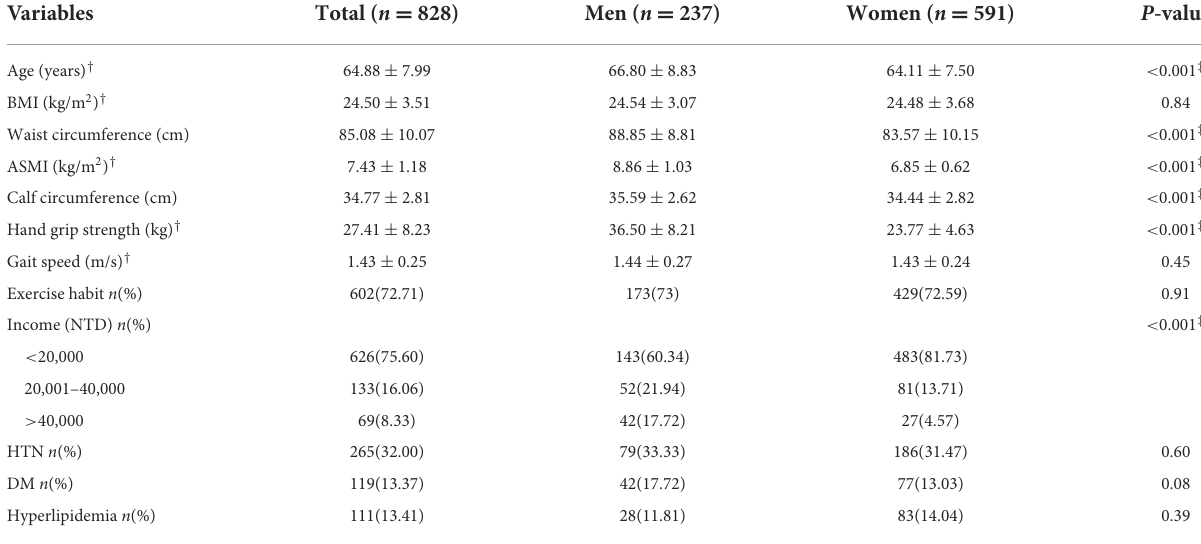
TABLE 1 Baseline characteristics of participants by